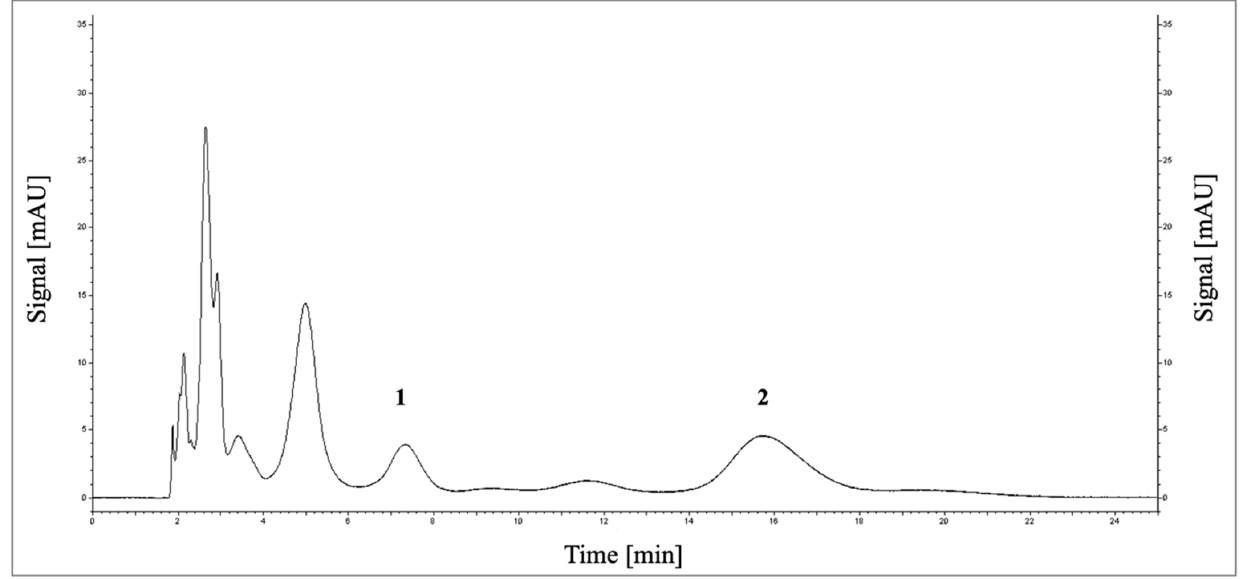
Figure 4. Chromatogram (reversed-phase high-performance liquid chromatography (RP-HPLC)) for the analysis of histamine ( 1 ) and thiamine ( 2 ) in the pancreatin-digested food matrix SIF after 90 min.